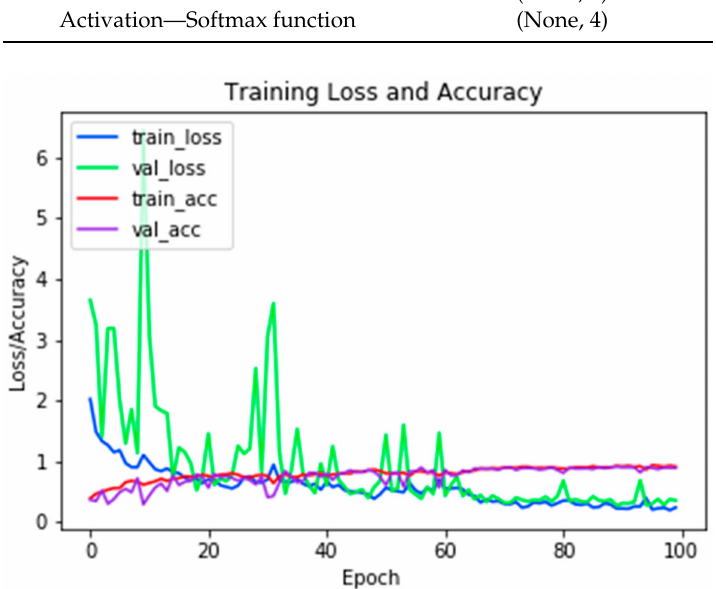
Figure 3. Learning history of the classifier obtained using the created